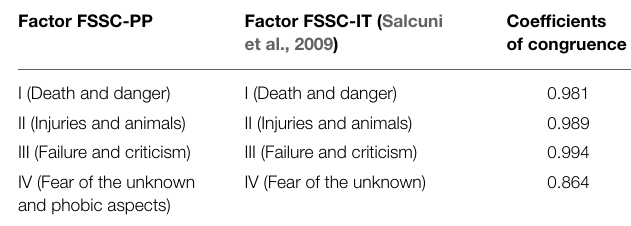
TABLE 4 | Boys’ and girls’ means and standard deviations on FSSC-PP factors and overall fears level. Factor Gender